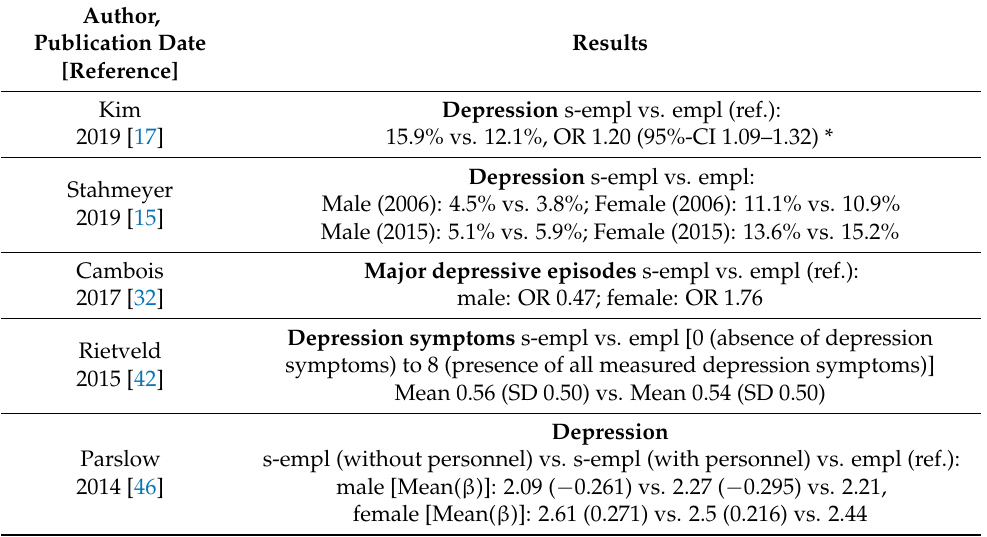
Table 6. Depression —results of cross-sectional studies of good quality on mental disorders compar- ing self-employed (s-empl) vs. employees